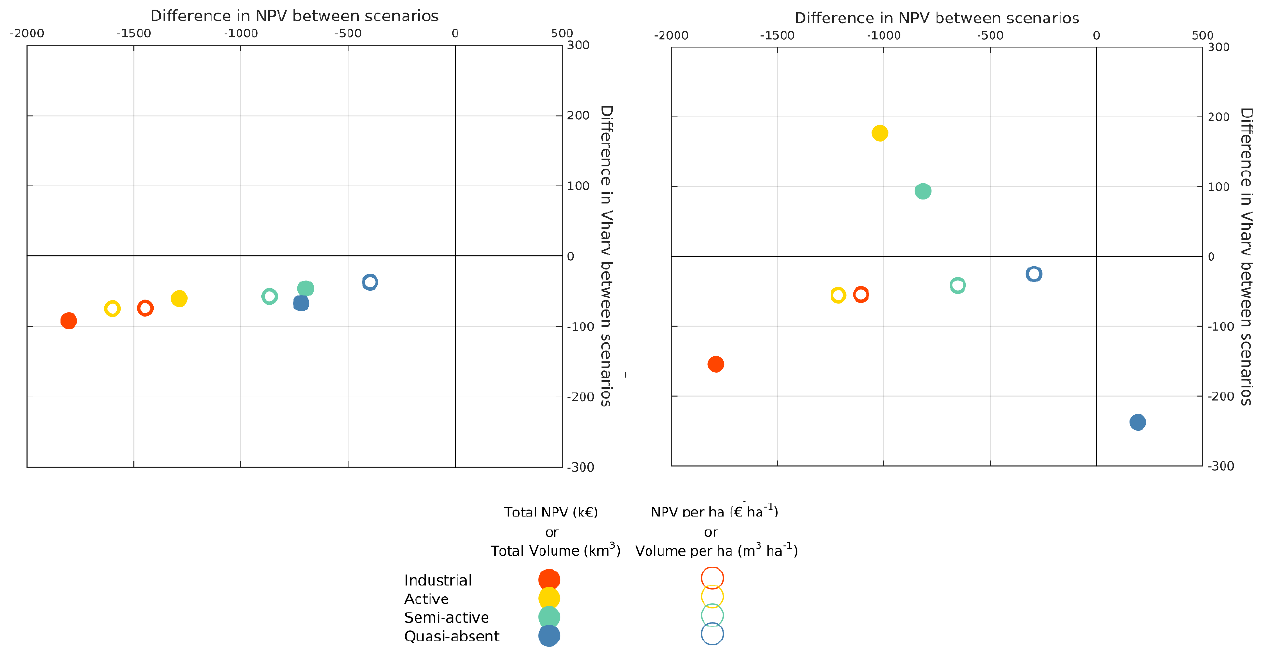
Figure 5. Net present value and volume harvested losses by owner type when comparing the BAU (FBN0/3_MCur_F1_C0) and the improved management scenario (FBN3/3_MHgh_F1_C0) with the hypothetical scenario with no fire (FBN0/3_MCur_F0_C0); where the full circles represent differences in “10 3 m 3 / 10 3 €” and bordered circles “m 3 ha − 1 / € ha − 1 ” losses.